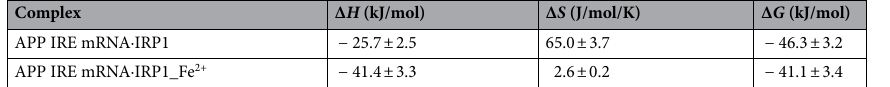
Table 2. Thermodynamic parameters of enthalpy (Δ H ), entropy (Δ S ), and Gibb’s free energy (Δ G ) for the interactions of APP IRE mRNA with IRP1. ΔG values were calculated using the equation ΔG = ΔH − TΔS at 25